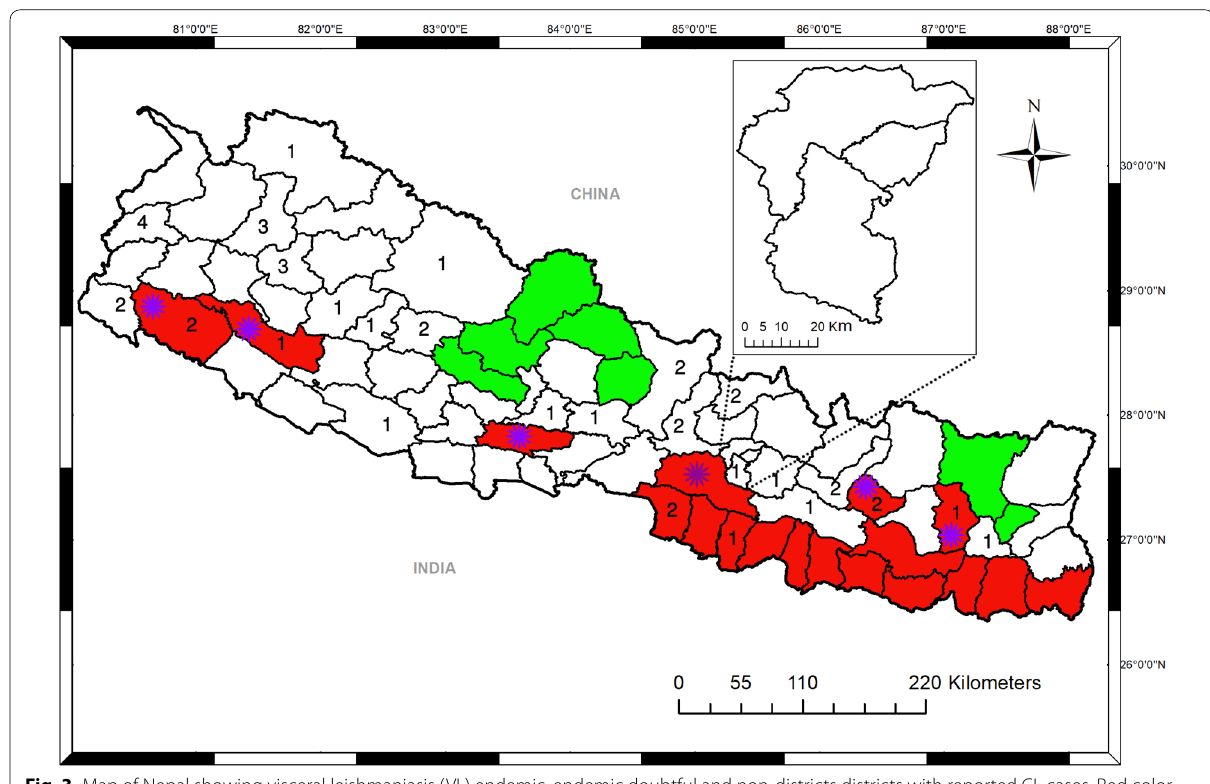
Fig. 3 Map of Nepal showing visceral leishmaniasis (VL) endemic, endemic doubtful and non-districts districts with reported CL cases. Red color shows the VL-endemic districts ( n Numbers indicate CL cases distribution by district ( n